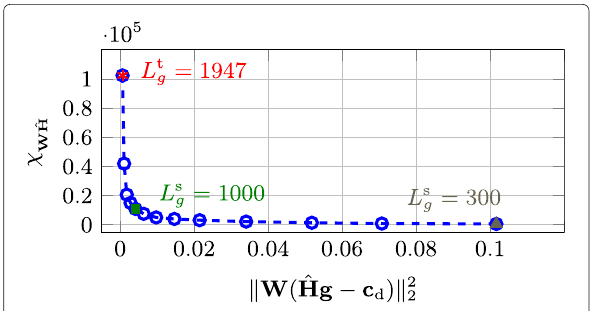
Fig. 4 Typical L-curve obtained using PMINT for several reshaping filter lengths ranging from L t g = 1947 to L s g = 300. The considered acoustic system is system S 1 described in Section